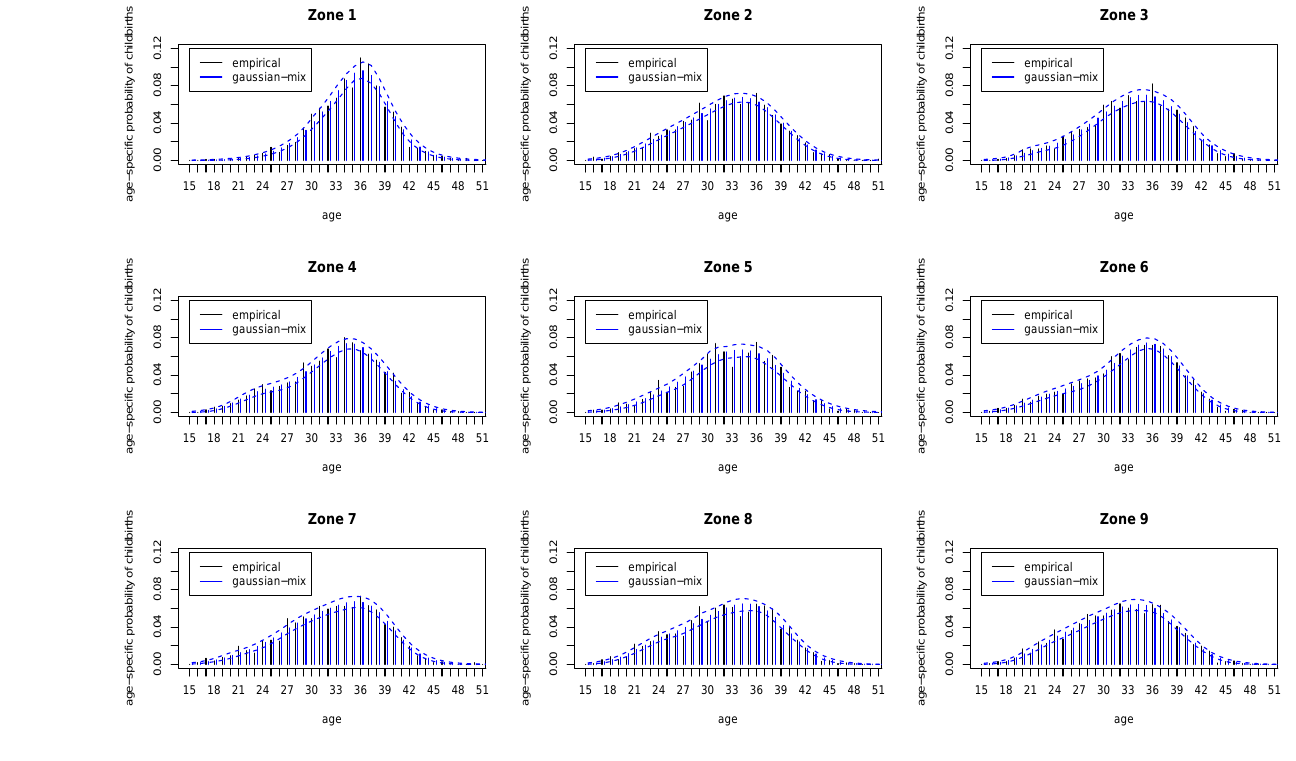
Figure 2 – Posterior mean probability mass function (blue bars) with pointwise 95% credible bands (dashed blue lines) and empirical probability mass function (black bars) for the age of the mother at childbirth in the nine Milan